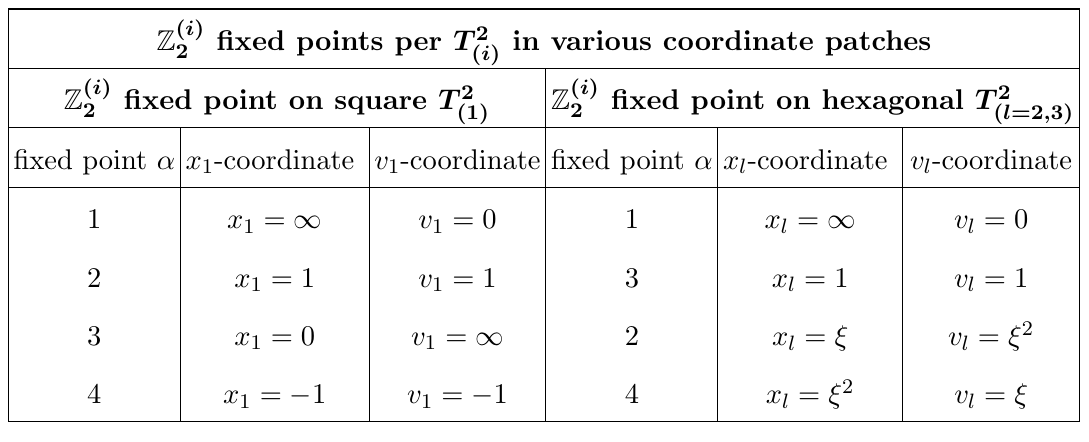
Table 27 . Overview of the Z ( i ) (cid:12)xed points on the square torus T 2 and the hexagonal tori T 2 2 (1) ( l =2 ; 3) in the homogeneous coordinates x i ( v i = 1 patch) for the second and (cid:12)fth column, and in the homogeneous coordinates v i ( x i = 1 patch) for the third and last column. The labelling of the (cid:12)xed points matches the one in (cid:12)gure